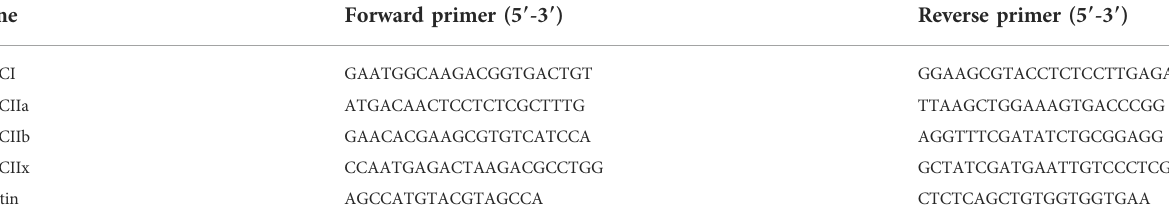
TABLE 2 Rat MHC isoforms and β -actin controlprimersused for qRT-PCR. Forward and reverse primer pairs are indicated for the four MHC isoforms.